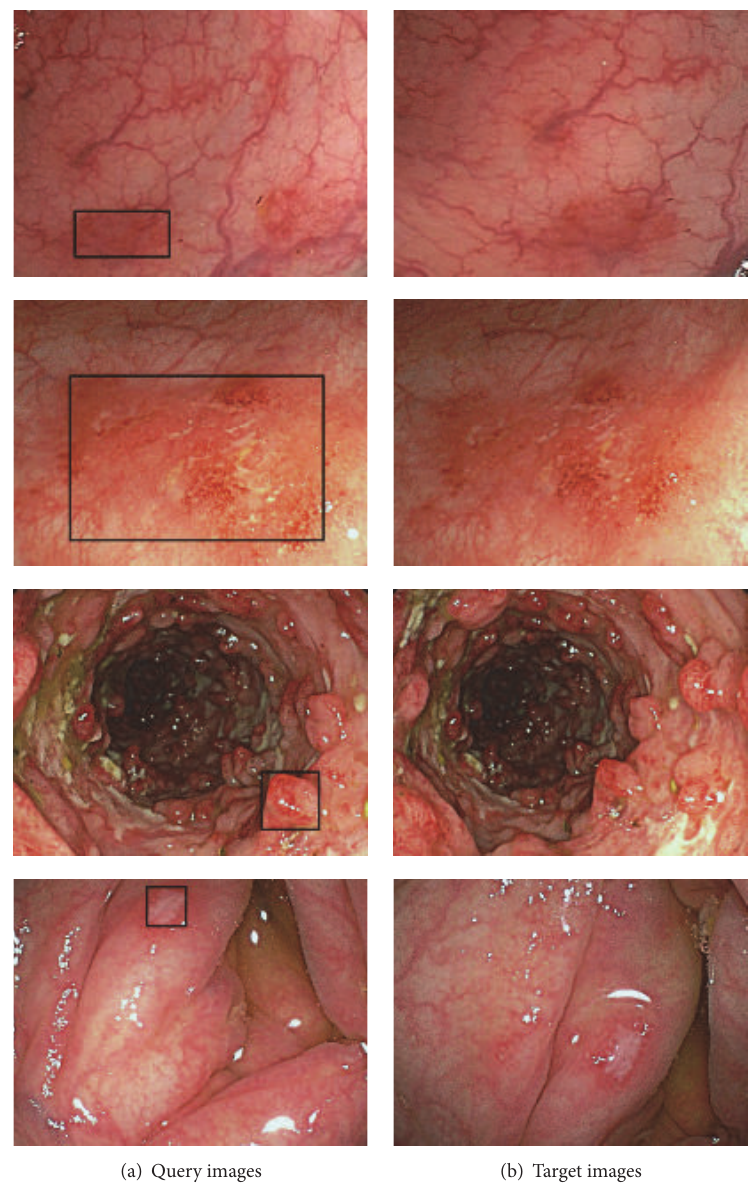
Figure 13: Four pairs of different images for the same mucosal symptom.